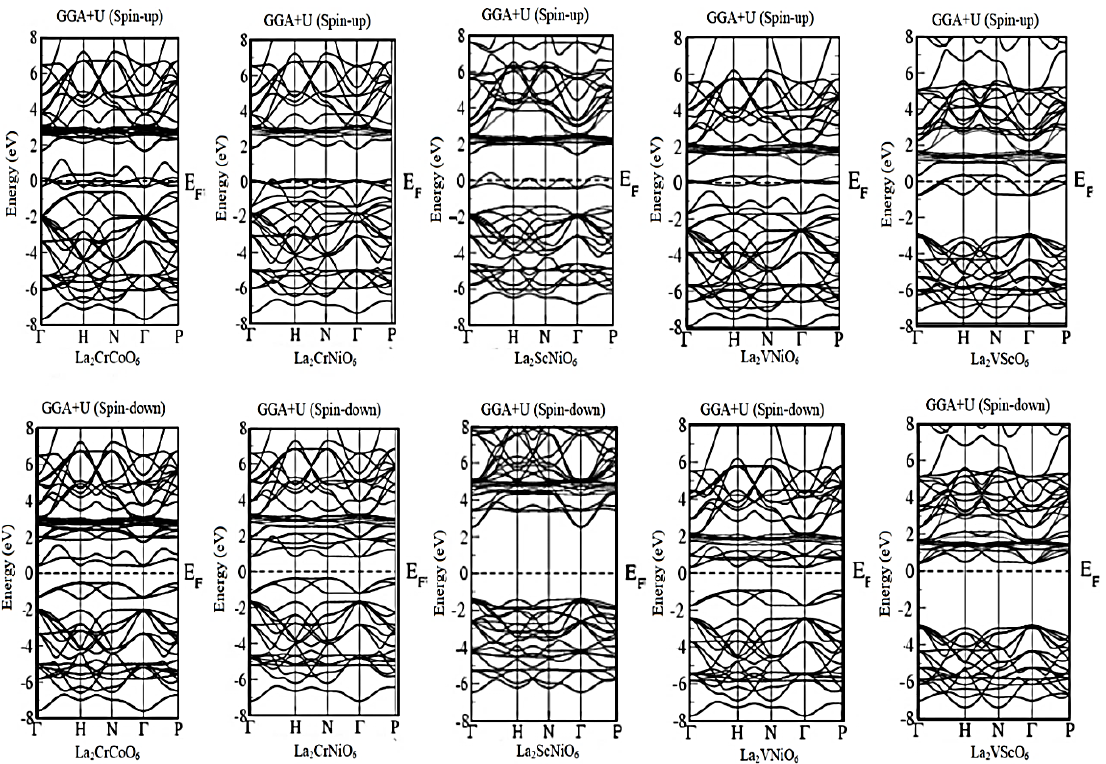
Figure 3. Band structures of DPC La 2 BB ′ O 6 using GGA+U in both spin ‐ up and spin ‐ down channels.